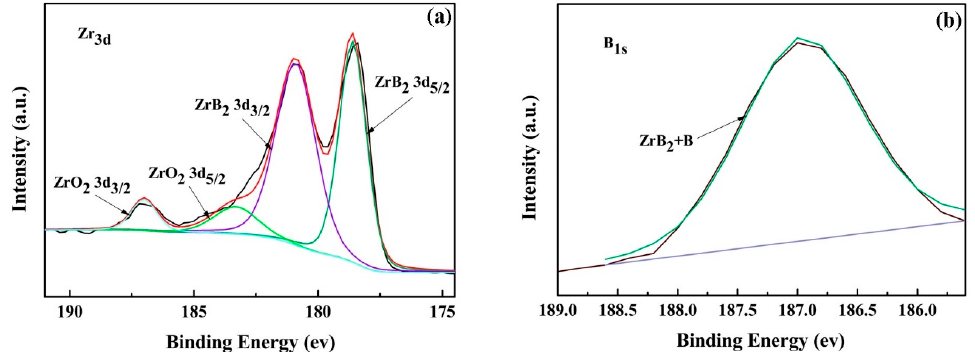
Figure 4. High resolution XPS spectra of ( a ) Zr 3 d and ( b ) B 1 s of Zr-B-O nanocomposite films with 80 W sputtering power of ZrB 2 target.